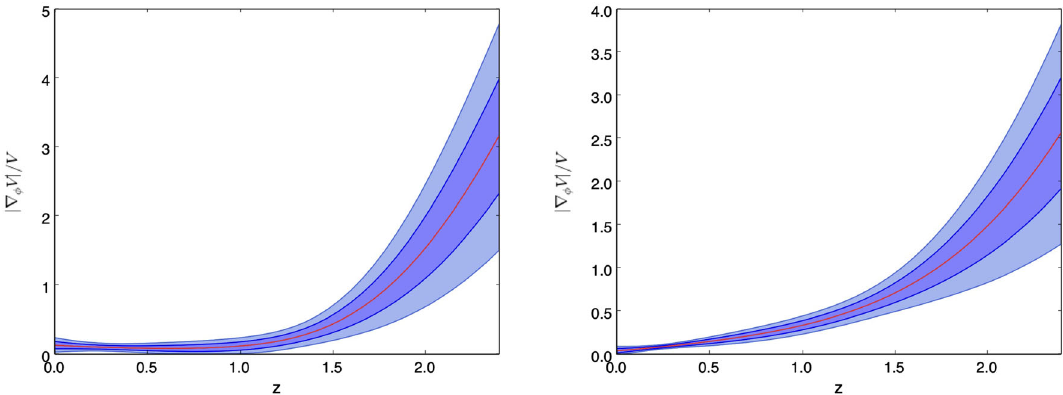
Fig. 12 The GP reconstruction of | V (cid:3) | / V , Eq. (27), for the 30 H ( z ) samples deduced from the differential age method with 10 additional samples obtained from the radial BAO method (Table 1) is presented on the left hand side plot, when H 0 = 73 . 52 ± 1 . 62 km s − 1 Mpc − 1 has been merged to the expansion rate data used in the GP. The right hand side plot represents the GP reconstruction of | V (cid:3) | / V , Eq. (27), when